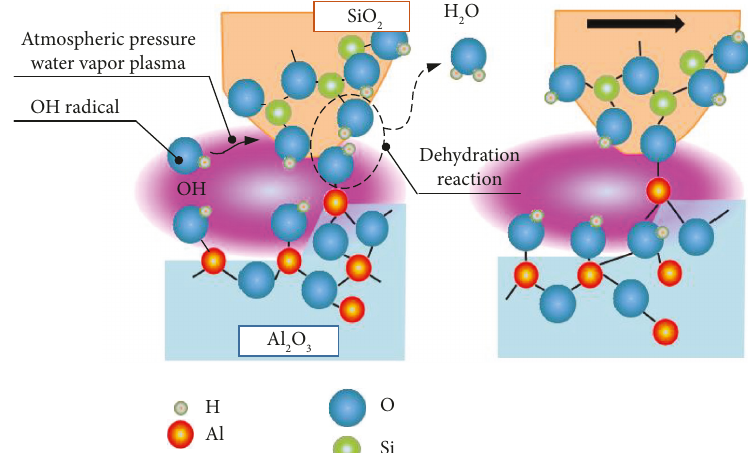
Figure 20: Proposed model of removal for sapphire in PAP